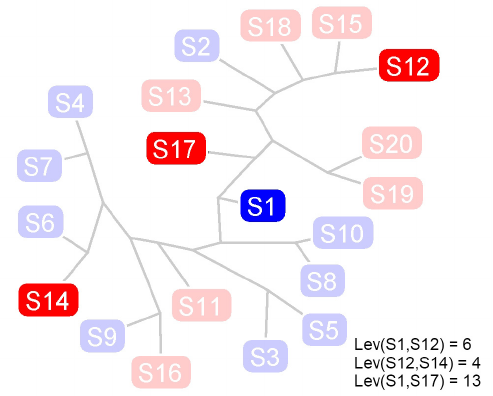
Figure 2. Tree-graph from eyePatterns with highlighted